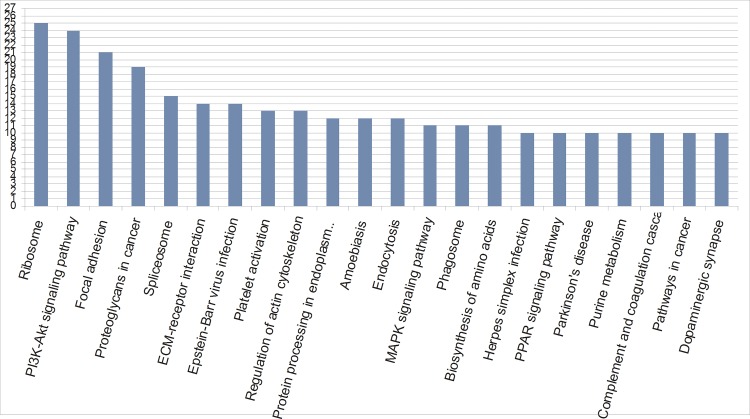
Distribution of KEGG pathways in the pituitary proteome.